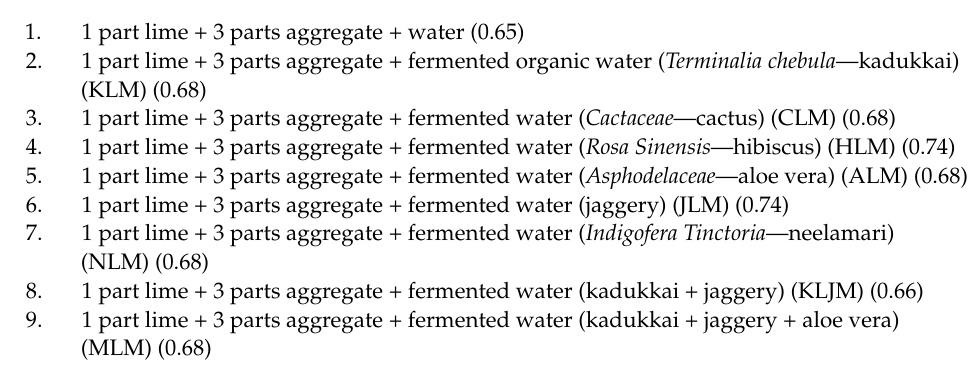
Algorithm 1. Description of the lime mortar mix proportions.